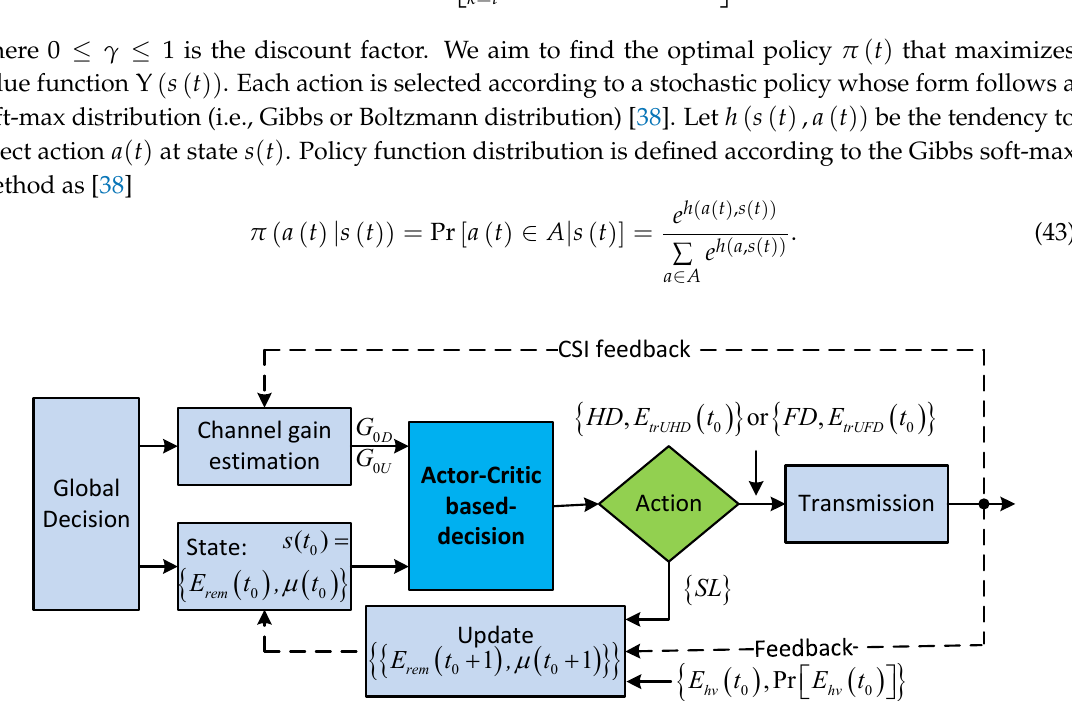
Figure 6. Flowchart of the proposed scheme when applying actor-critic learning method.